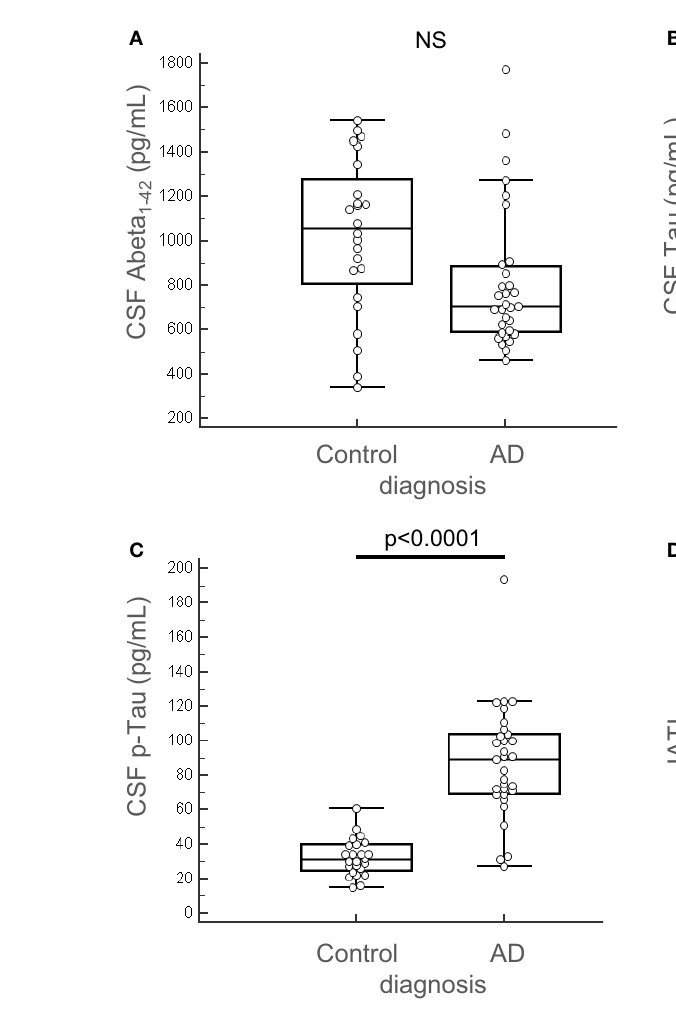
(A–C) . IATI ratio [A β 42/(240 + 1,18tau)] (D) was calculated for every subject of the cohort. Outliers are indicated with black circle. Outliers are defined as a value that is smaller than the lower quartile minus three times the interquartile range, or larger than the upper quartile plus three times the interquartile